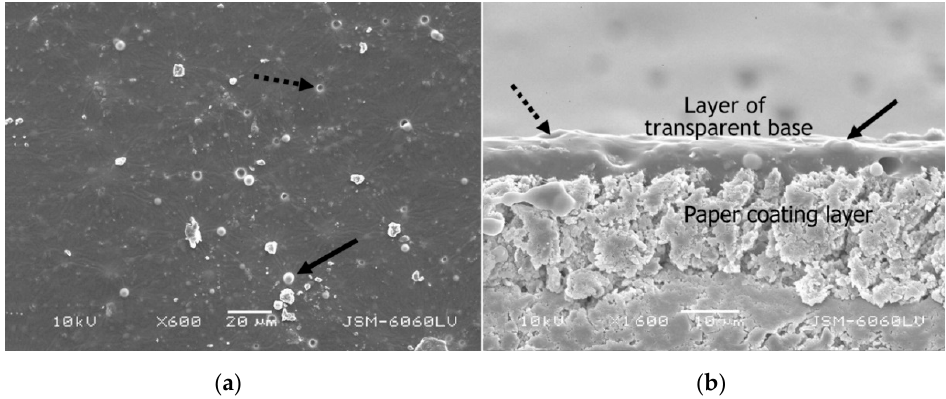
Figure 2. ( a ) Surface morphology (mag. 100×); ( b ) cross-section of transparent base applied on coated paper and (mag. 600×); solid arrow points to polymer sphere, dotted arrow points to micro void.